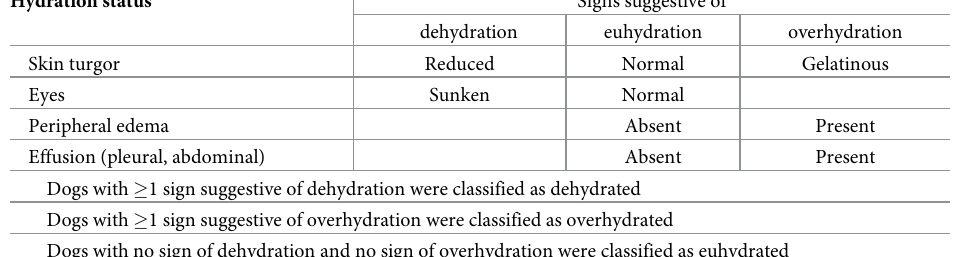
Table 1. Criteria used for the clinical assessment of the vascular volume and hydration status. Vascular volume status Signs suggestive of hypovolemia Heart rate � 160 bpm < 160 bpm Pulse Quality Weak Normal or strong Capillary refill time � 2 sec < 2 sec Acral temperature Cold Normal